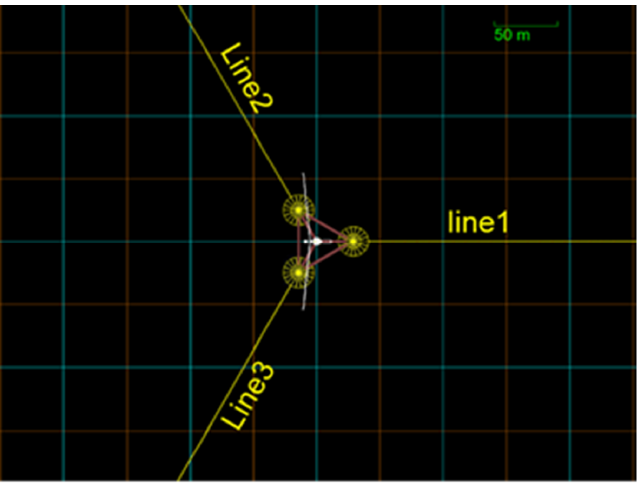
Figure 8. Mooring design arrangement.